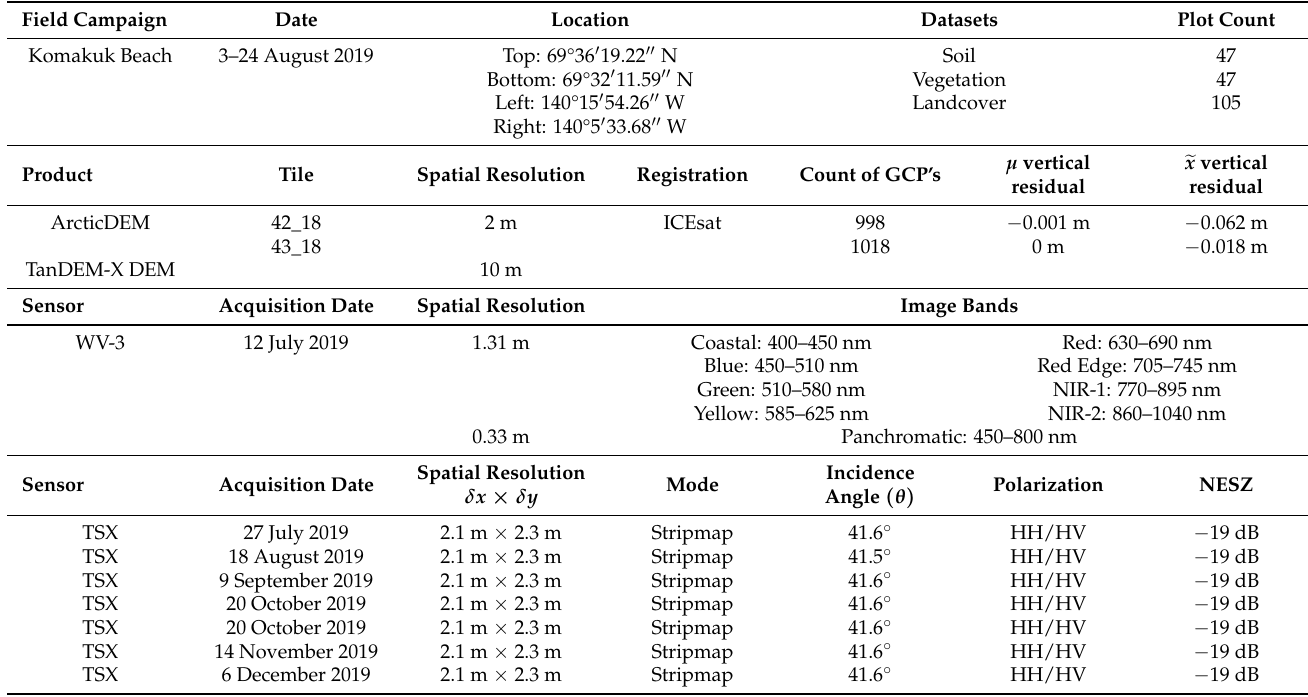
Table 1. Data sources and specifications. ArcticDEM = Arctic Digital Elevation Model [49], WV-3 = WorldView-3 [50], TSX = TerraSAR-X [51], GCP = Ground Control Point, µ = mean, (cid:101) x = median, δ x = ground range resolution, δ y = azimuth